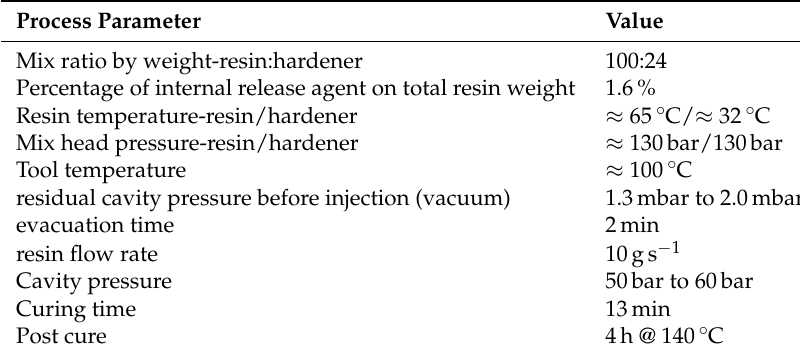
Table 5. RTM-process